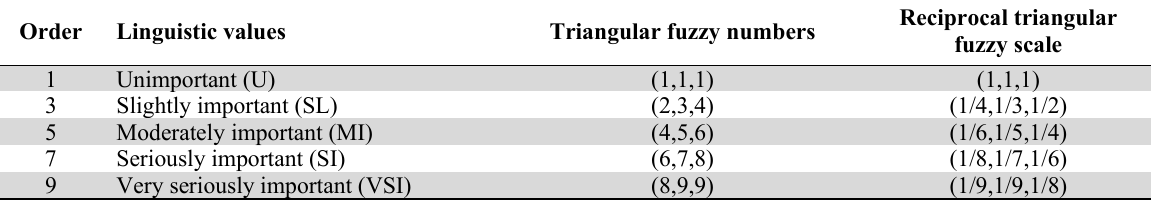
Reciprocal triangular fuzzy